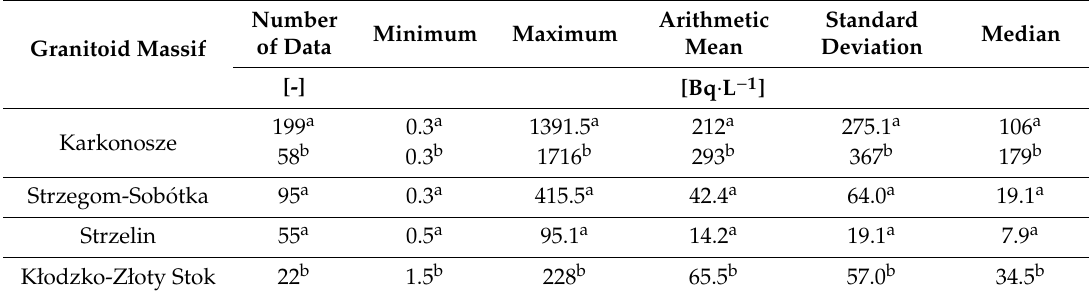
Figure 7. Kłodzko-Złoty Stok granitoids. Groundwater sampling sites plotted together with the type of collected water by 222 Rn content according to Przylibski’s classification [2]. Table 2. Archival descriptive statistic values for 222 Rn activity concentration in groundwaters from granitoid massifs of Poland.